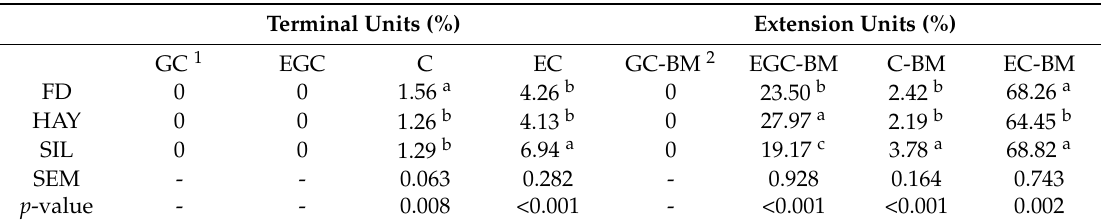
Table 2. Flavan-3-ol composition (% molar percentages) in condensed tannins of whole-plant purple prairie clover conserved as freeze-dried forage (FD), hay (HAY) or silage (SIL). Terminal Units (%)